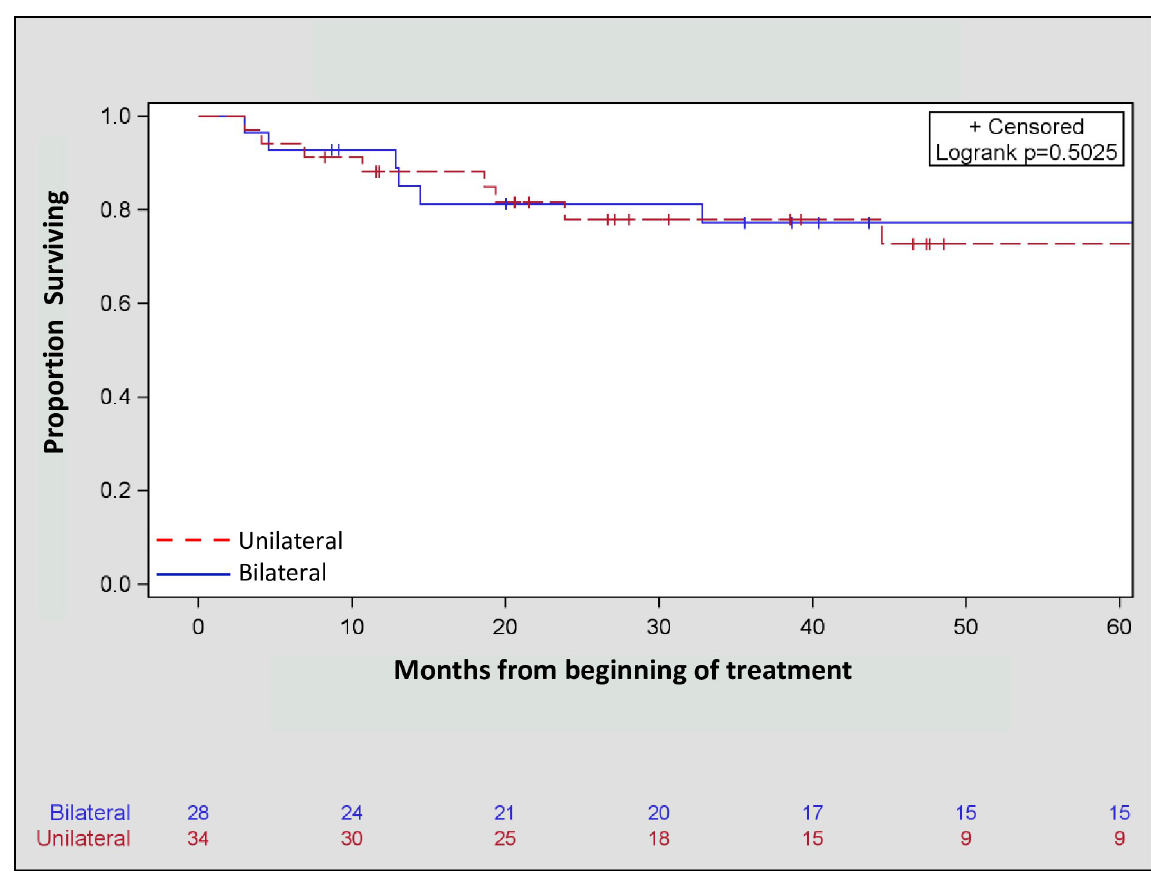
Fig 1. Kaplan-Meier three-year overall survival of unilaterally (77.90%) and bilaterally (71.67%) treated patients with squamous cell carcinoma of the head and neck with unknown primary (p = 0.50).